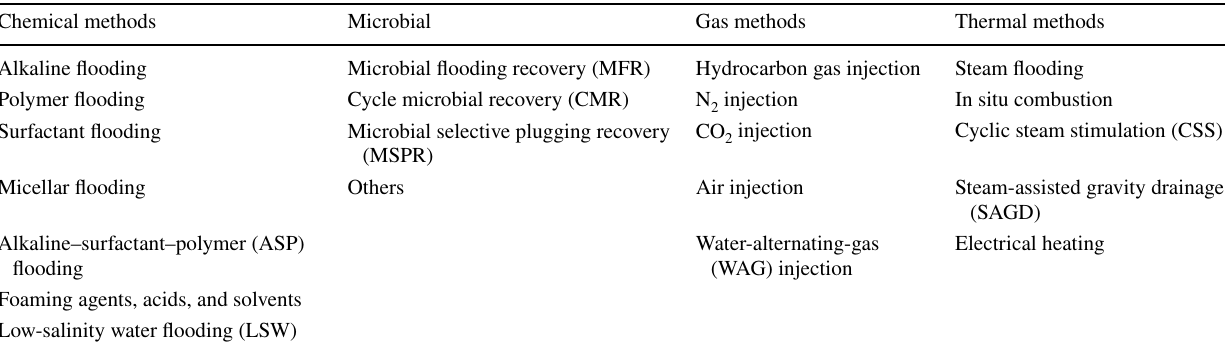
Table 1 Different methods of conventional EOR Chemical